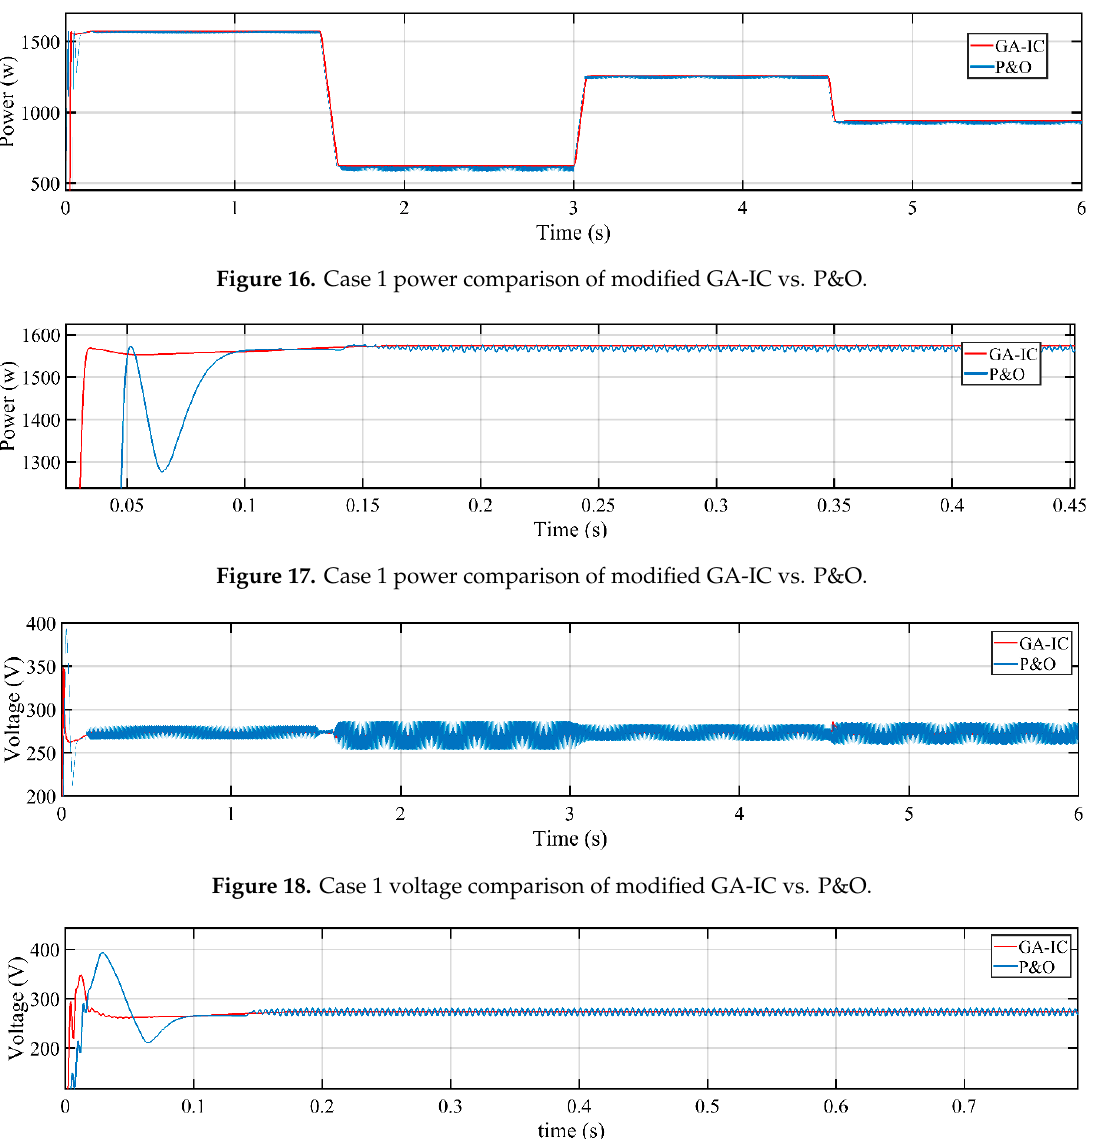
Figure 19. Case 1 voltage comparison of modified GA-IC vs. P&O.